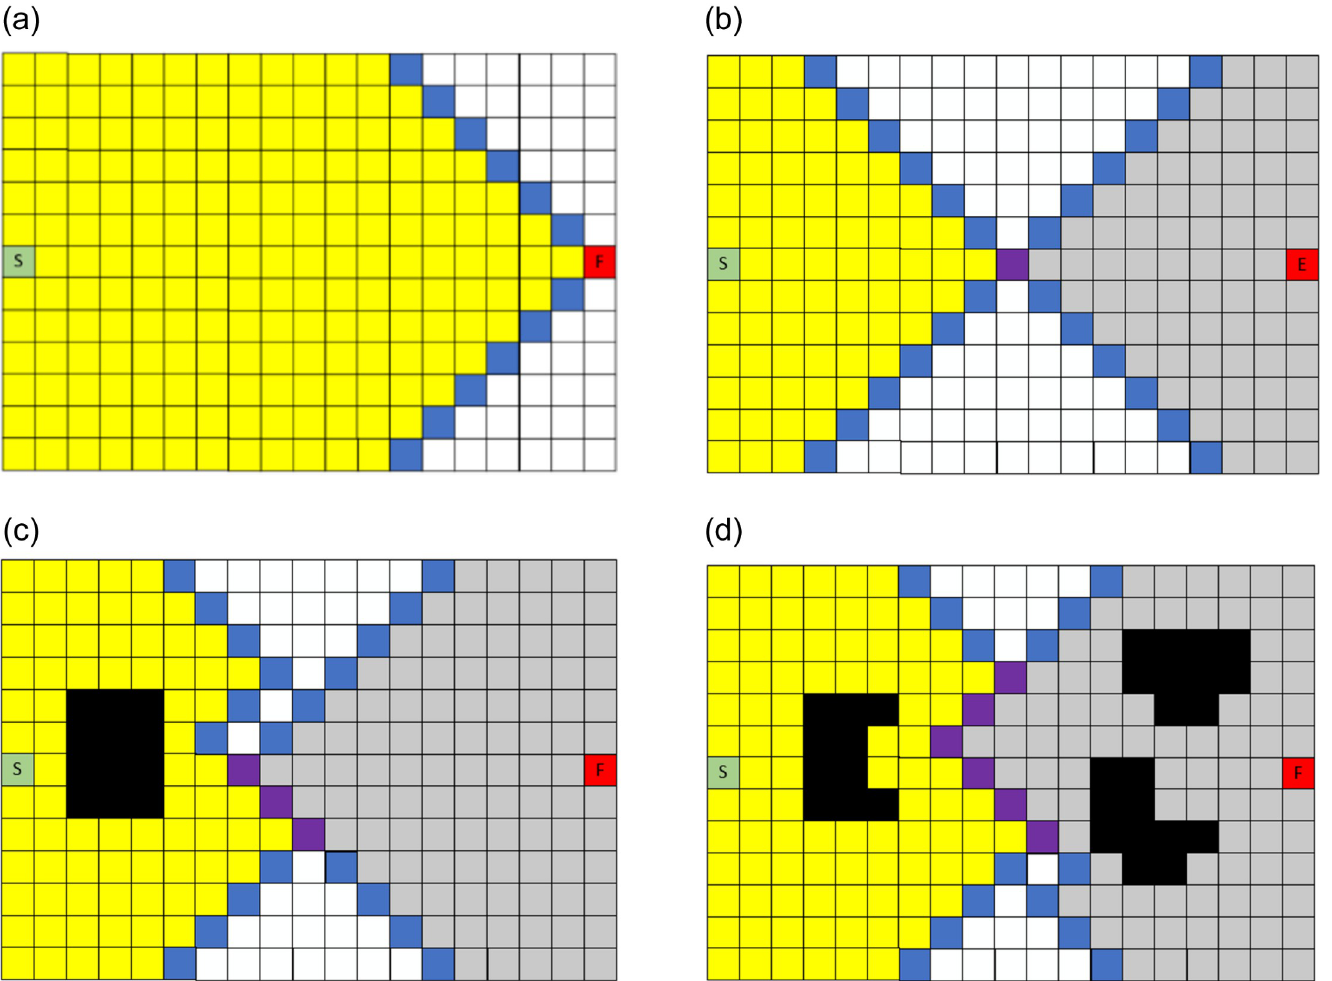
Fig 3. Schematic diagrams of bidirectional search. (a) Unidirectional search. (b) Bidirectional search without obs. (c) Bidirectional search with an obstacle. (d) Bidirectional search with multiple obstacles.